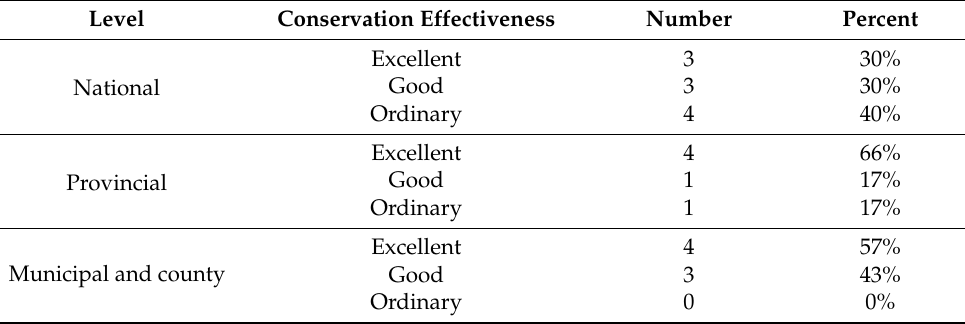
Table 9. Statistics of evaluation results of reserves based on protection